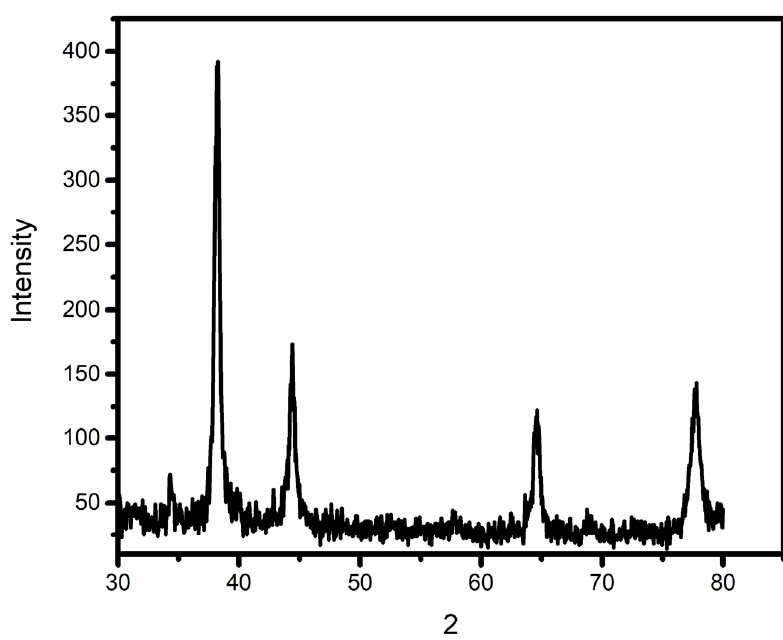
Figure 4. X-ray Diffractogram of the Carduus edelbergii mediated AuNPs.